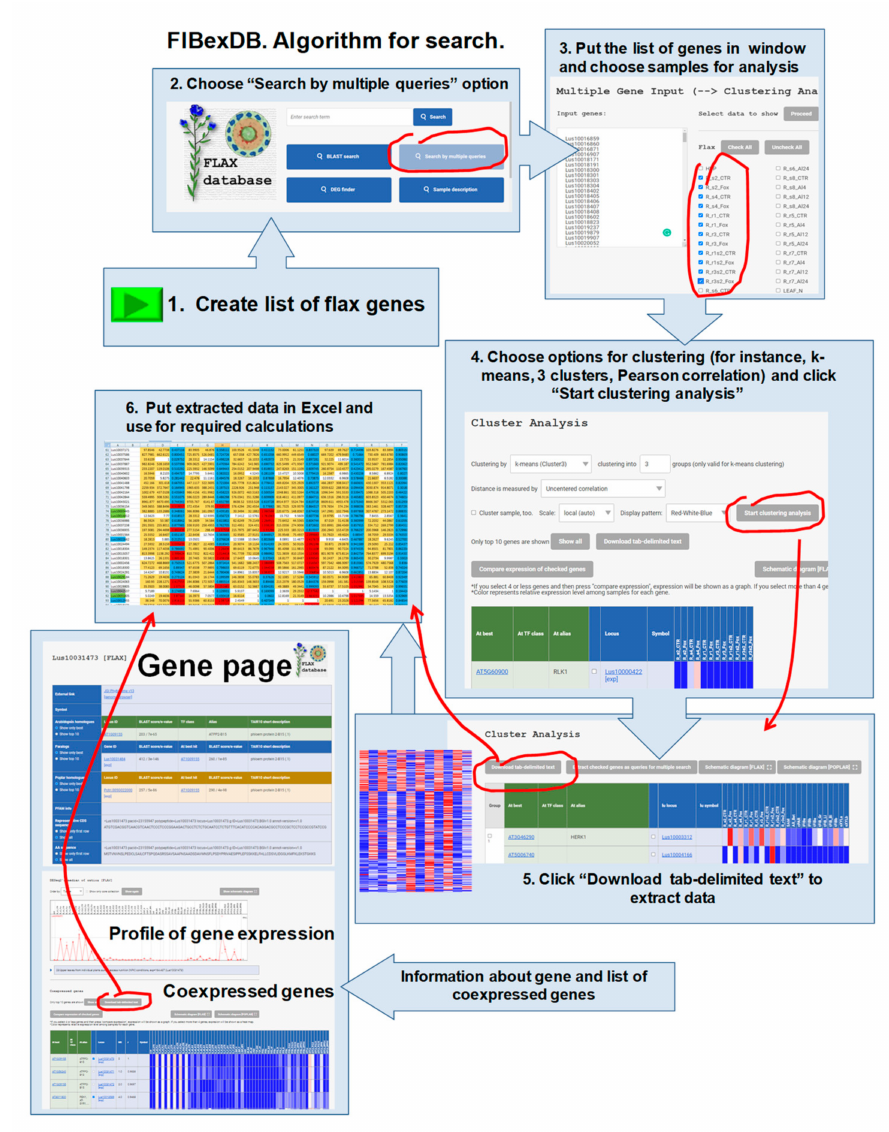
Figure 8. How to use FIBexDB for the analysis of expression